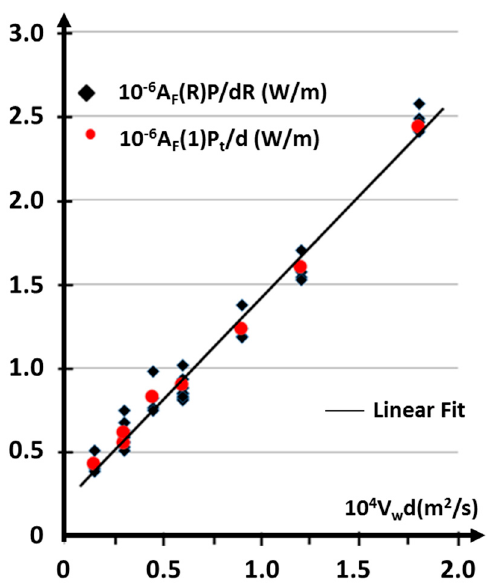
Figure 5. Plot of A F (1)P t /d and A F (R)P t /dR as a function of (V w d) and corresponding best linear fit.